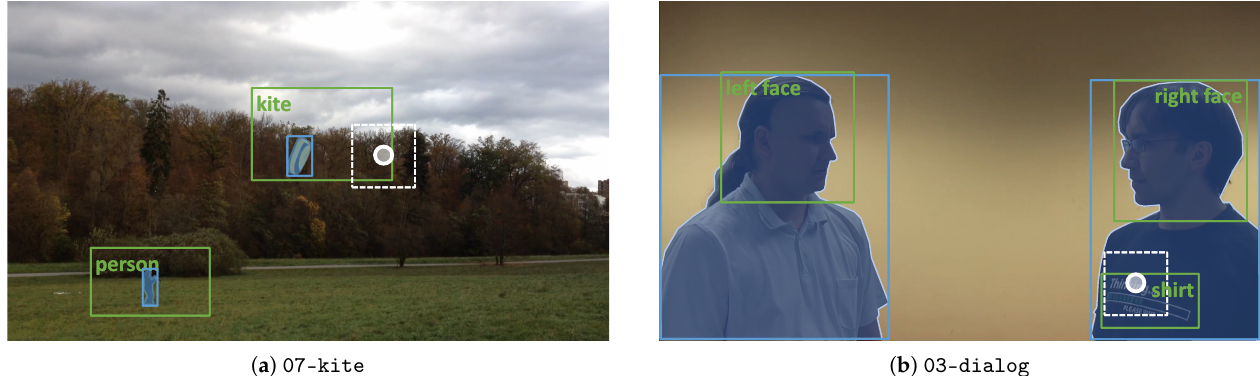
Figure 7. Example frames from two scenarios of the VISUS dataset [2] showing the recent fixation (white circle), ground truth annotations (green), object masks and bounding boxes for OD (blue), and the cropping area for IC (white